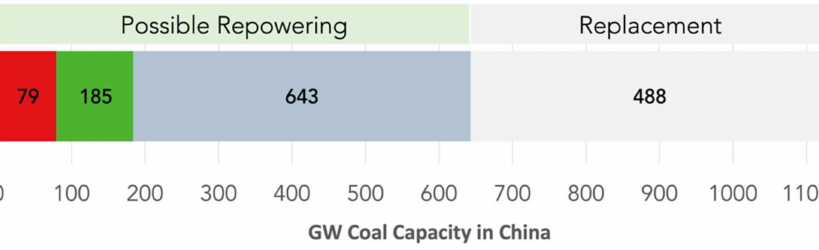
Figure 3. Capacity distribution of China’s three-step